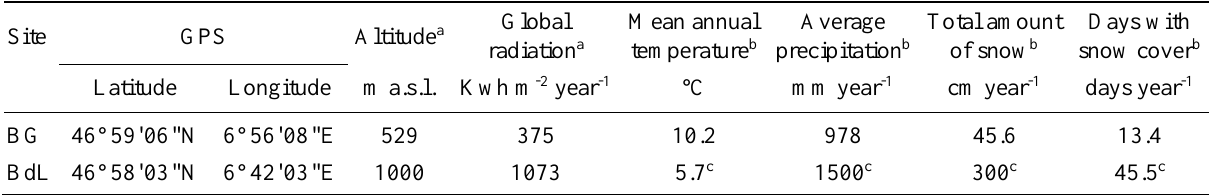
91.7 %, BdL: 83.3 %), the remaining being half dry or possibly already dead. Table 1. Location and long-term (1981–2010) climatic characteristics (MétéoSuisse 2016, 2017) of the two study sites.